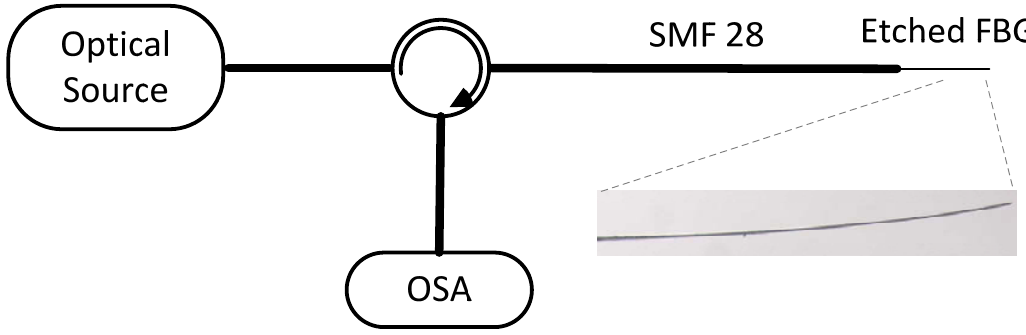
Figure 2. Strain sensor experimental